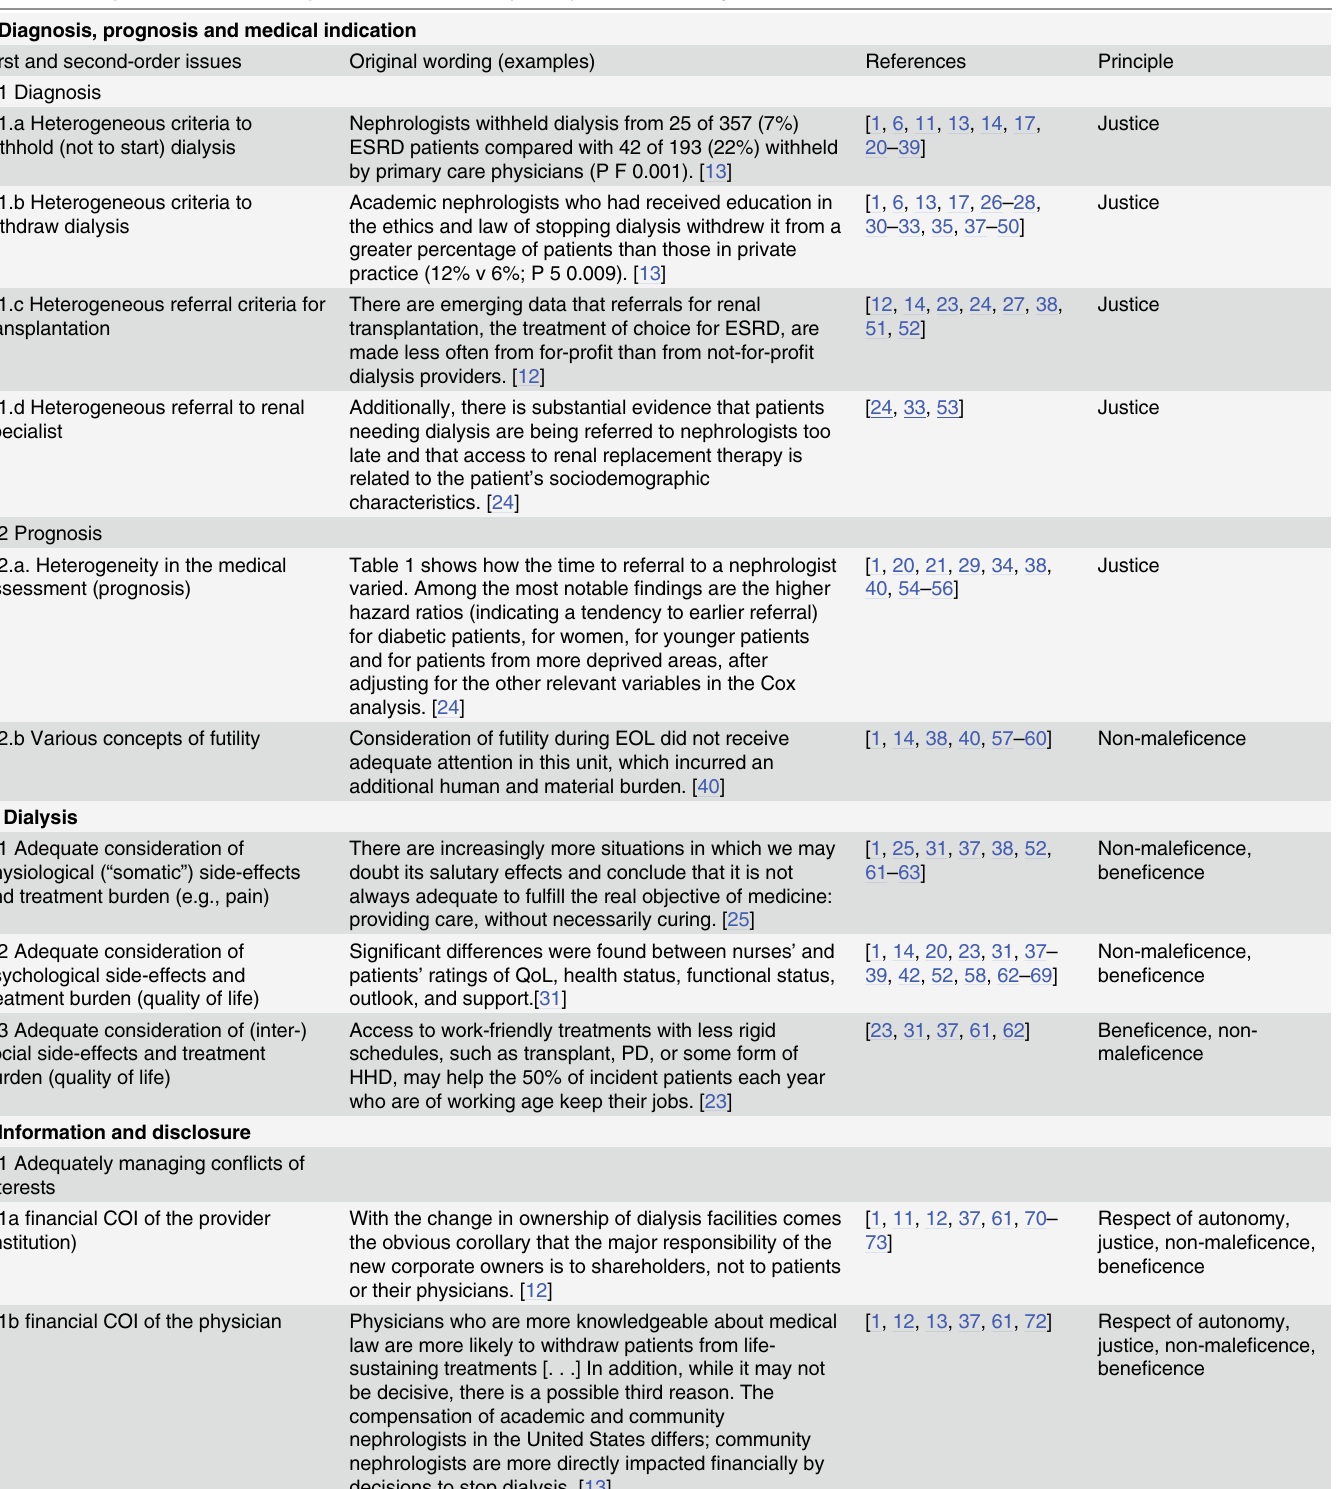
Table 1. The spectrum of disease-specific ethical issues (DSEIs) issues in kidney failure. 1 Diagnosis, prognosis and medical